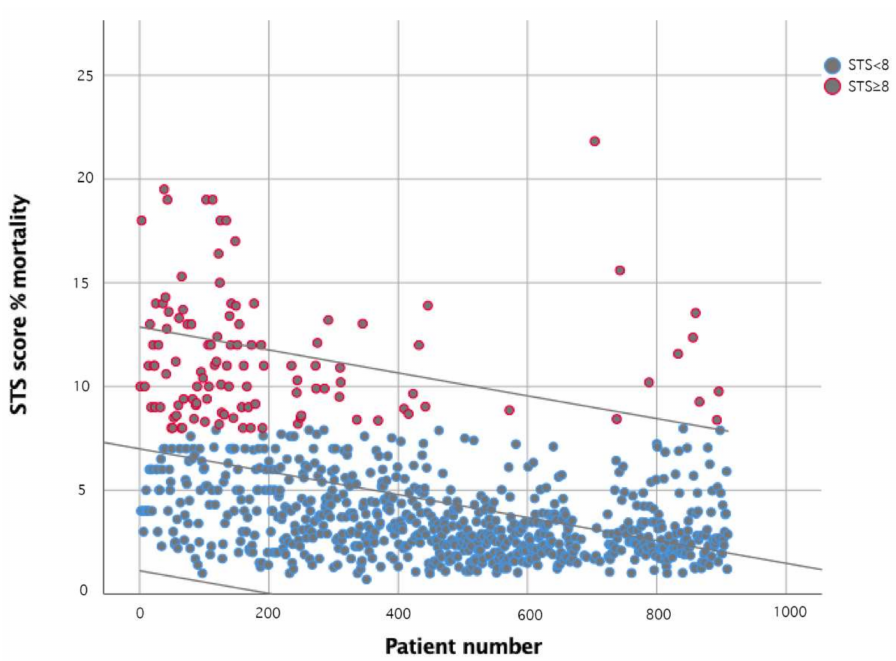
Figure 1. STS Score over time. Scatterplot with interpolation line, demonstrating the reduction of the patient’s risk as defined by STS score over time, from patients 1–910. Individual patients are represented by circles and divided into either a low-intermediate risk group (STS < 8) or high-risk group (STS ≥